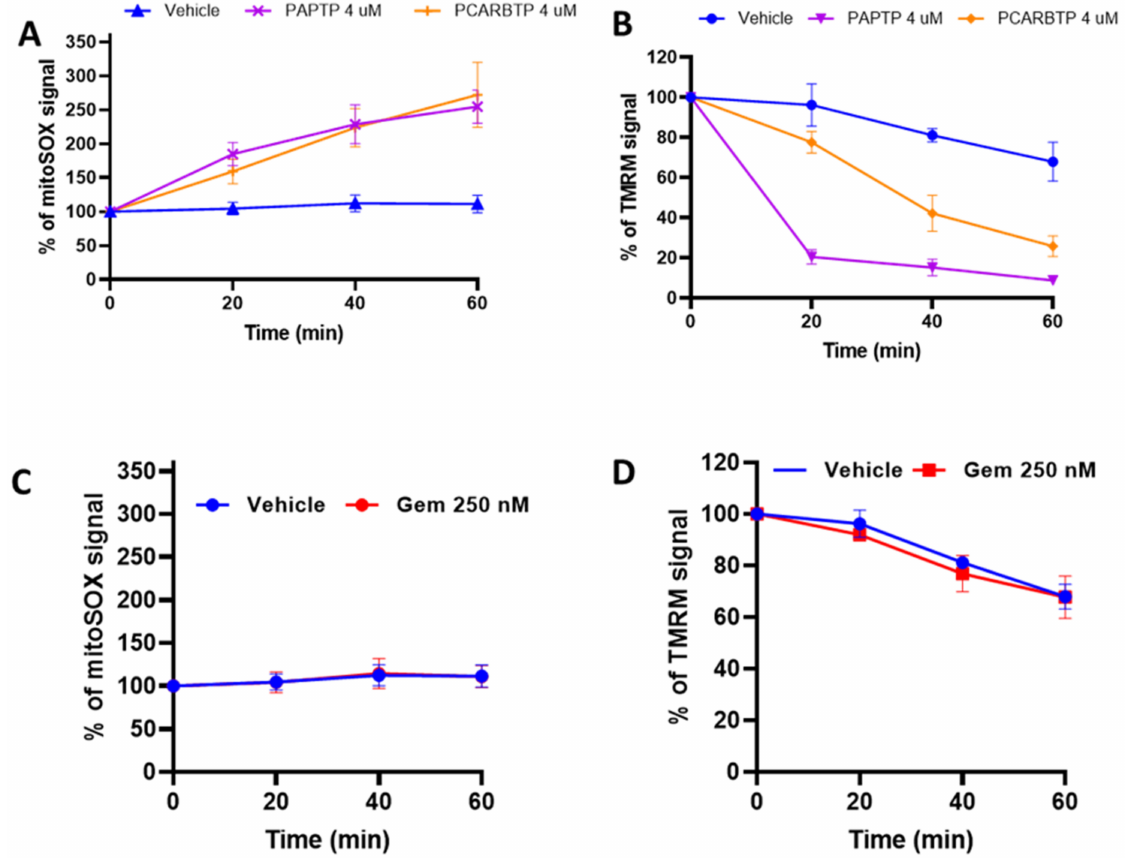
Figure 8. Direct effects of PCARBTP/PAPTP alone or when combined with Gemcitabine (GEM) and Abraxane on Mitochondria. ( A ) Mitochondrial ROS production was tested using MitoSOX on Pan02 cells treated with PCARBTP/PAPTP . The compounds increased ROS level. Mean normalized values ± SD from four biological replicates are shown. ( B ) Mitochondrial membrane potential was followed using 5 nM TMRM on Pan02 cells treated with PCARBTP/PAPTP for the indicated time. In these experiments, the probe was not washed off so as to allow further uptake following hyperpolarization. Results are shown as mean ± SD from four biological replicates. ( C ) Mitochondrial ROS production on Pan02 cells treated with GEM. ( D ) Mitochondrial membrane potential on Pan02 cells treated with